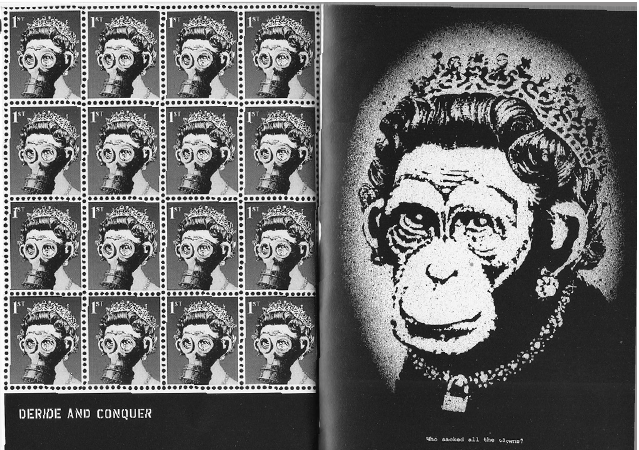
Fig. 2 Banksy, Deride & Conquer / Who sacked all the clowns? (Banksy, 2001, pp. 46,